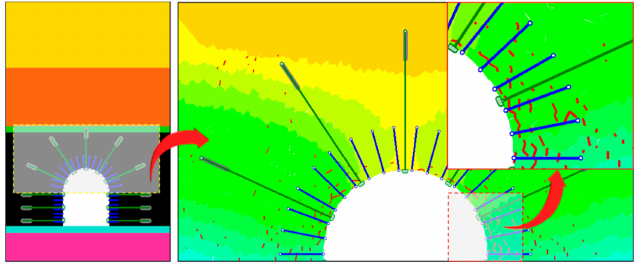
Figure 17. Control e ff ect of cracks in the chamber